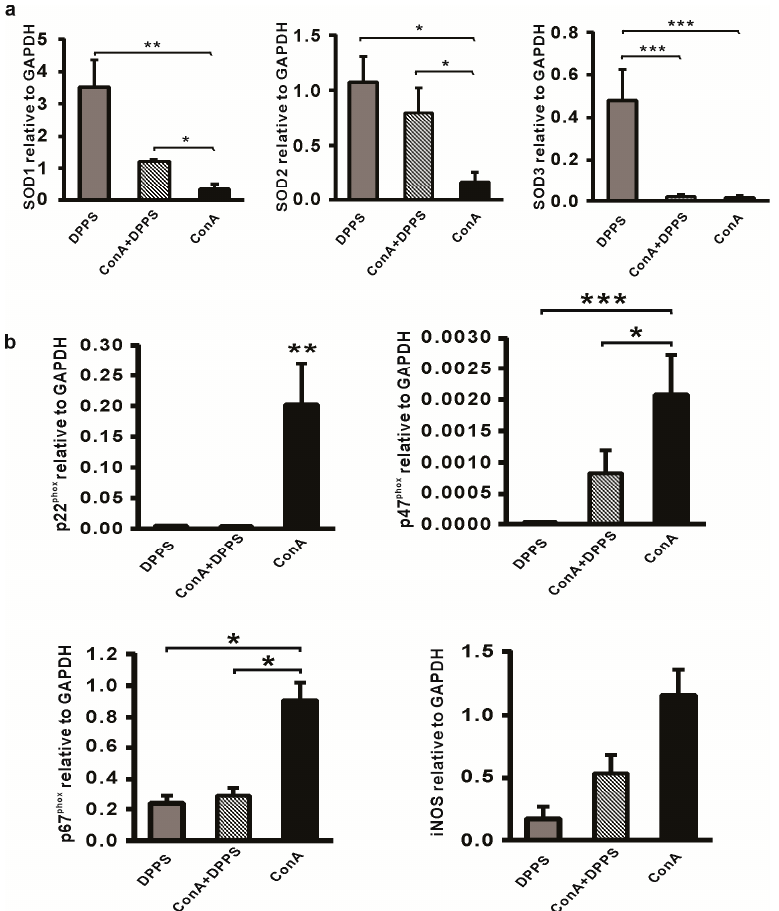
Figure 4. Pretreatment with DPPS shows hepatoprotective effects in ConA-induced hepatitis. mRNA levels of ( a ) SOD1, SOD2, SOD3 and ( b ) p22 phox , p47 phox , p67 phox , iNOS in livers determined using real-time qRT-PCR with GPDH as an internal control, 8 h after infection ( n = 5). Data are presented as mean + SE (*** p < 0.001; ** p < 0.005; * p <